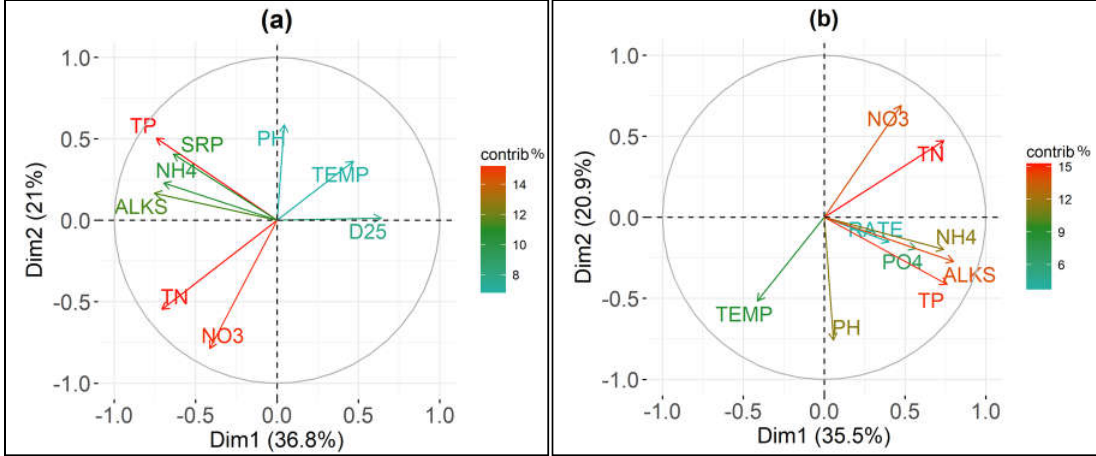
Figure 5. Loadings plots of the first two components of the principal component analysis (PCA) with different colors according to the parameters contributions (“contrib %”) performed on 8 chemico-physical parameters and ( a ) number of days elapsed from the beginning of the experimental procedure until an ammonium concentration decrease equal to the 25% (D25); and, ( b ) oxidation rate of ammonium (OxRate). See “Materials and Methods” for abbreviations.